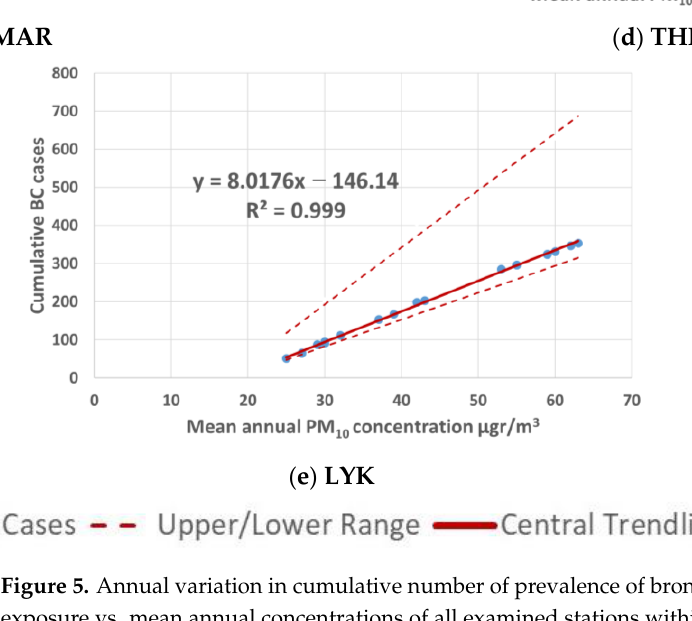
Figure 5. Annual variation in cumulative number of prevalence of bronchitis in children due to PM 10 exposure vs. mean annual concentrations of all examined stations within the GAA. Period 2001–2020. (( a ): ARI, ( b ): AGP, ( c ): MAR, ( d ): THR, ( e ): LYK).